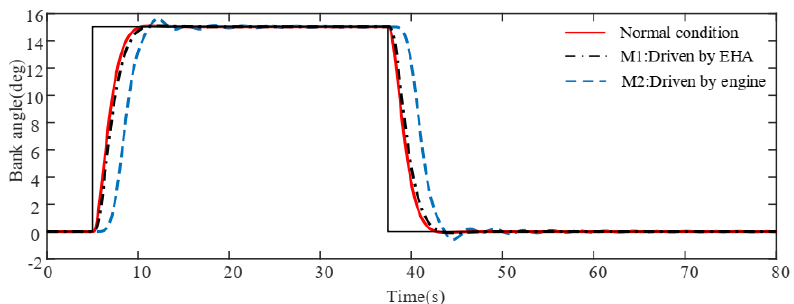
Figure 5. Sideslip angle response for damage scenario I.